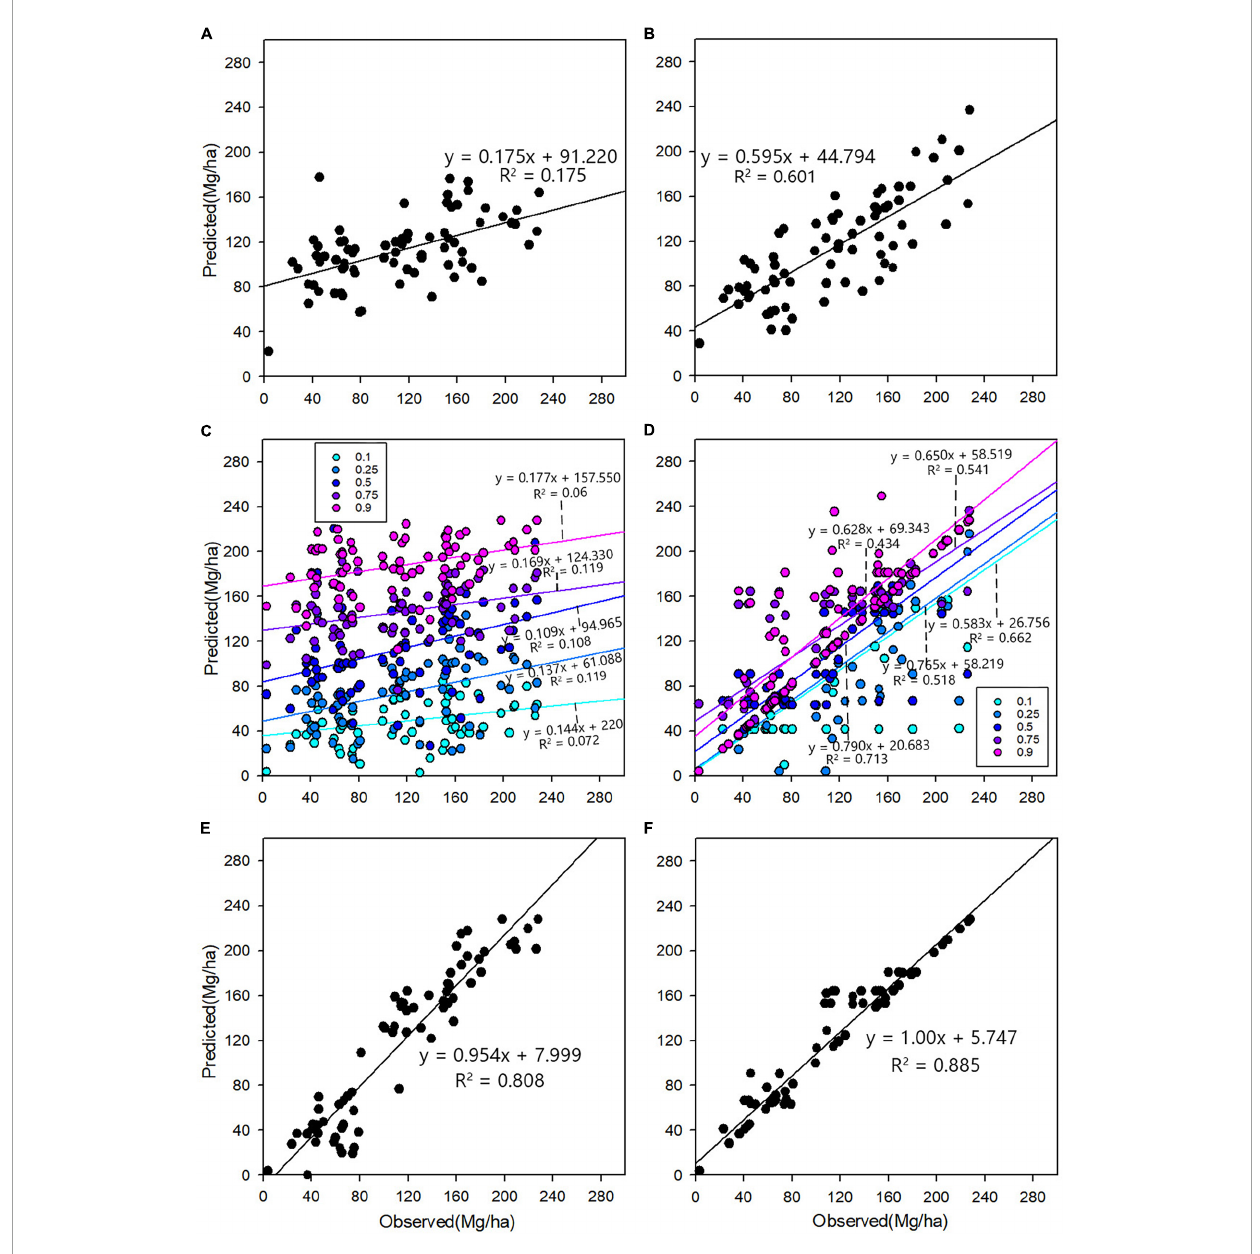
FIGURE3 The scatter graphs of the predicted plot AGB values against the observed or reference values based on the modeling dataset ( n = 73) (A) linear stepwise regression (LSR); (B) artificial neural network (ANN); (C) quantiles regression (QR): the quartiles groups are 0.1, 0.25, 0.5, 0.75, and 0.9, respectively; (D) quantiles regression neural network (QRNN): the quartiles groups are 0.1, 0.25, 0.5, 0.75, and 0.9, respectively; (E) the quantile regression with the best fitting performance in each biomass segment (QRb); and (F) the quantile regression neural network with the best fitting performance in each biomass segment